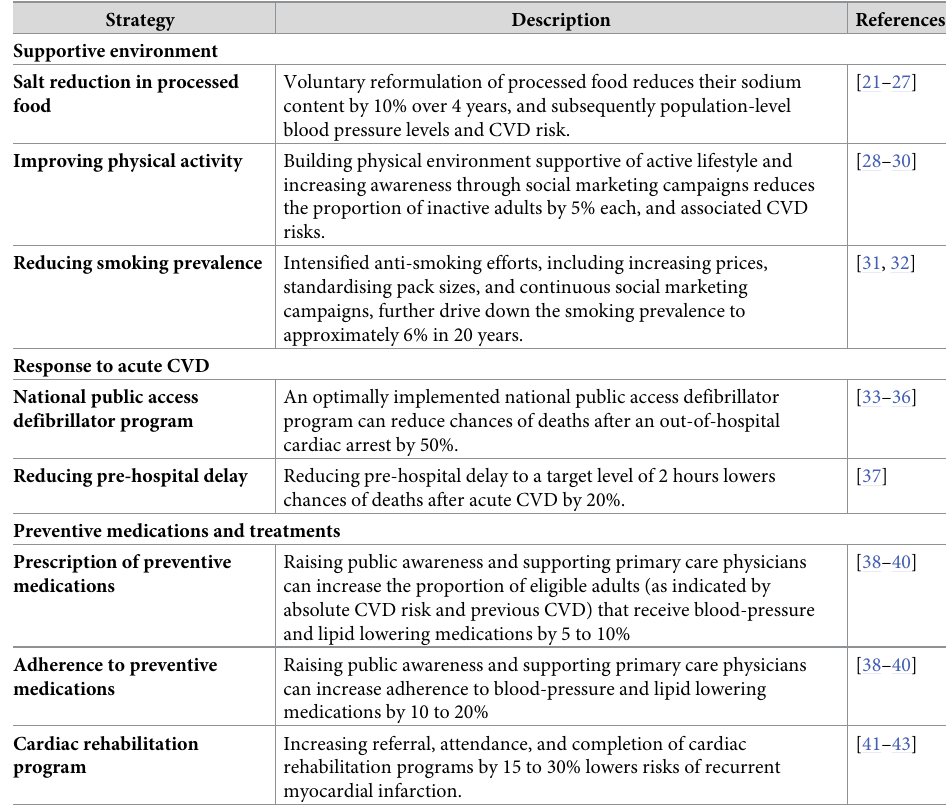
Table 1. Summary of strategies